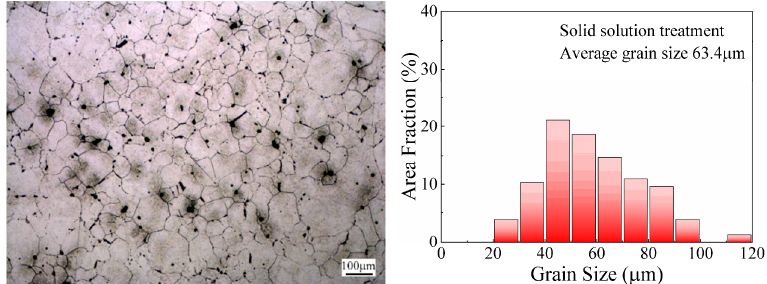
Figure 3. Microstructures and grain size distribution of 65Mn low-alloy steel subjected to solid solution treatment.